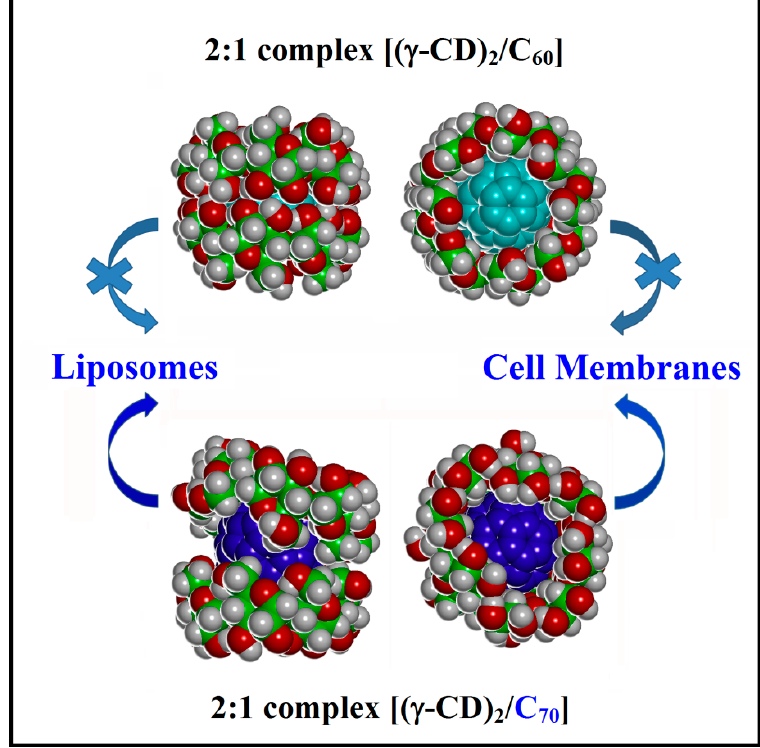
/ C 2 70 ] complex structure as obtained in the present